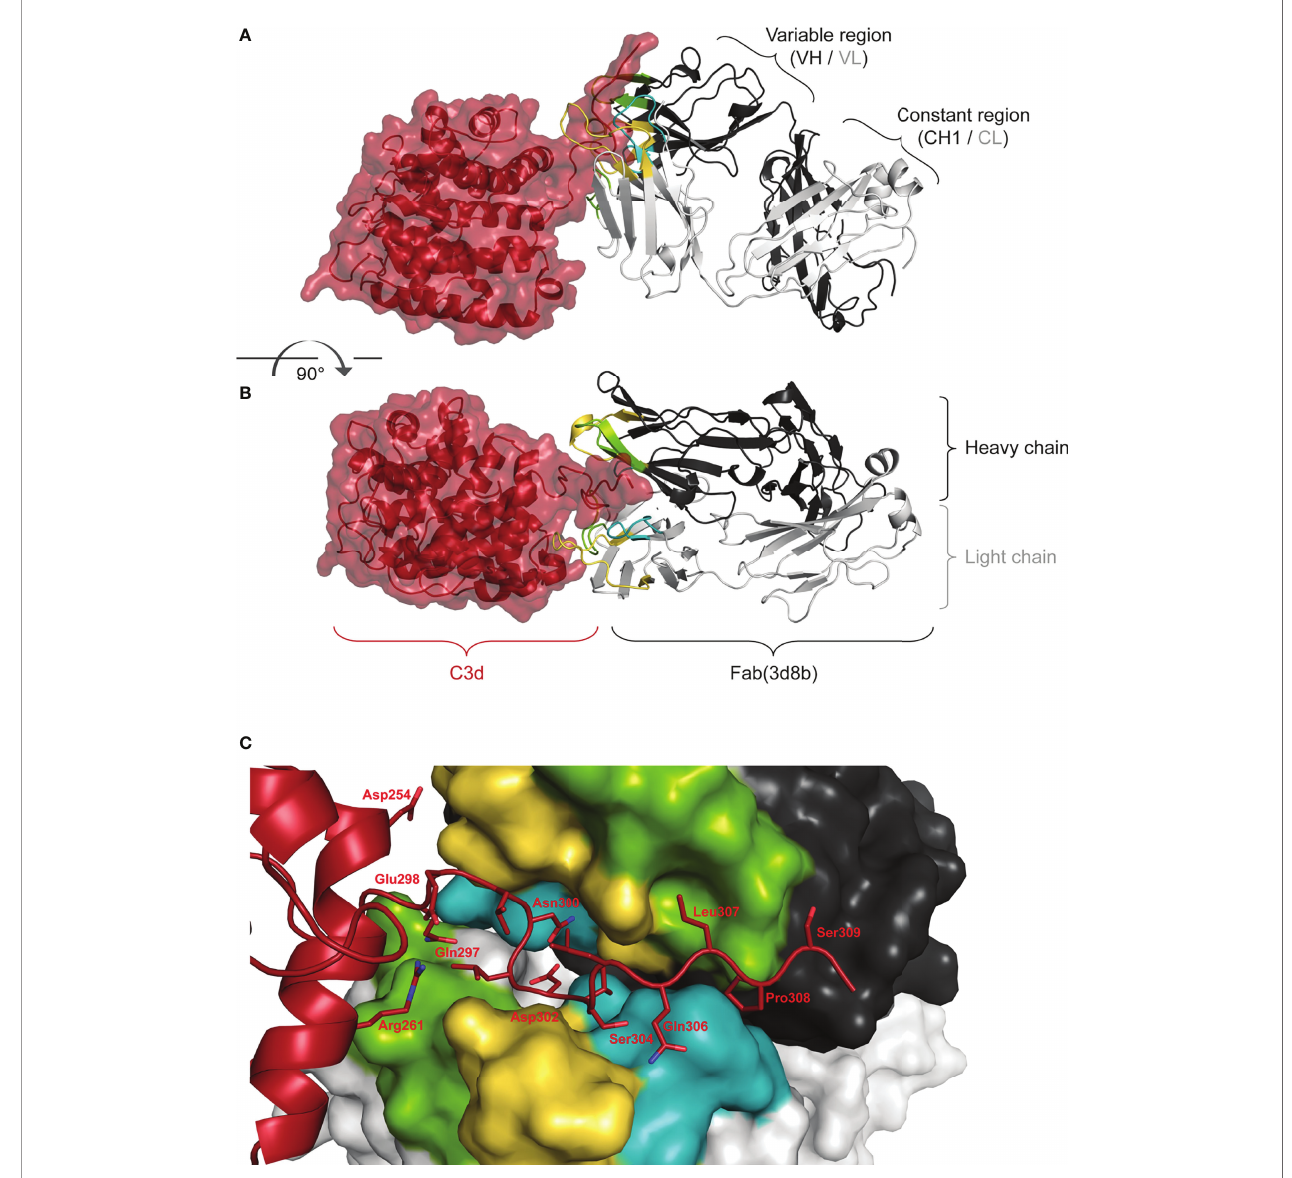
FIGURE 2 | Fab (3d8b) in Complex with human C3d. Paratope Fab heavy chain is shown in dark gray and the light chain in light gray, with CDRs H1/L1 in yellow, H2/L2 in green, and H3/L3 in teal; C3d is shown in dark red. Panel (A) is rotated approximately 90° to generate the view in panel (B) Epitope Panel (C) illustrates the extension of the C-terminal of C3d into the cleft between the heavy and light chain of the Fab (3d8b). Fab (3d8b) surfaces are shown for the heavy chain (dark gray) and the light chain (light gray), with CDRs highlighted in yellow (H1 and L1), green (H2 and L2), and cyan (H3 and L3). C3d a -carbon backbone is shown in dark red with side chain sticks (oxygen - red, nitrogen - blue) for residues within 5 Å of the